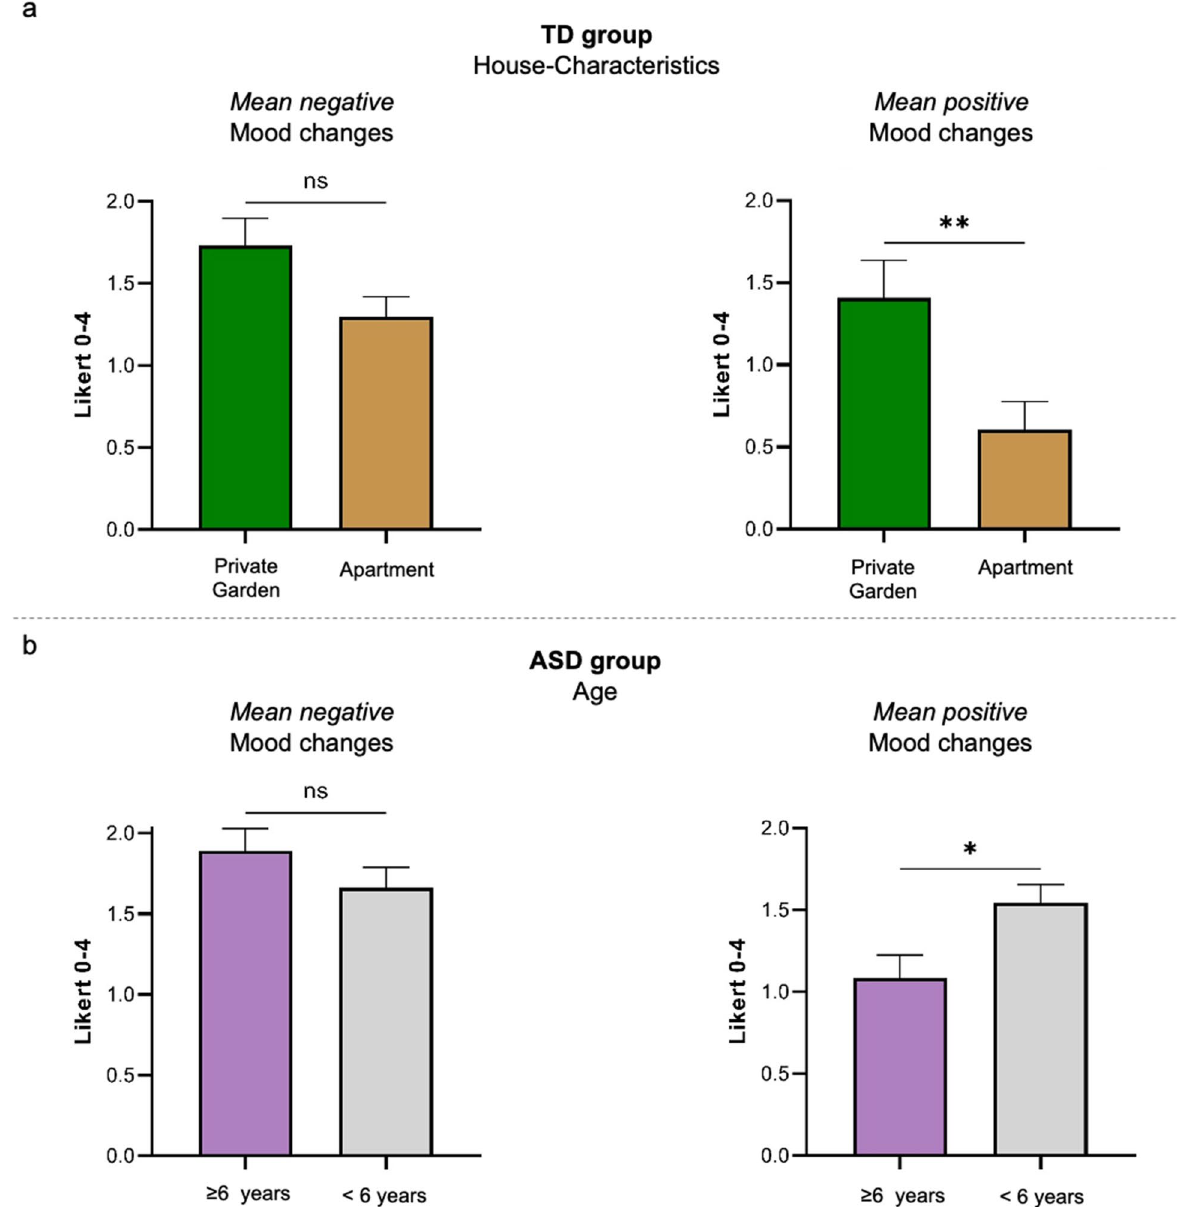
Figure 2. ( a ) Graphs illustrating the effects of House-Characteristics (private garden Vs. apartment) on the mean negative and mean positive mood changes within the TD group (p = 0.008). ( b ) Graphs illustrating the effects of Age (‘ ≥ 6 y.o.’ Vs. ‘ < 6 y.o.’) on the mean negative and the mean positive mood changes within the ASD group (p = 0.024). *Statistical significance, p < 0.05; **statistical significance, p < 0.01; ns = no statistical significance. Bars represent standard errors of the mean